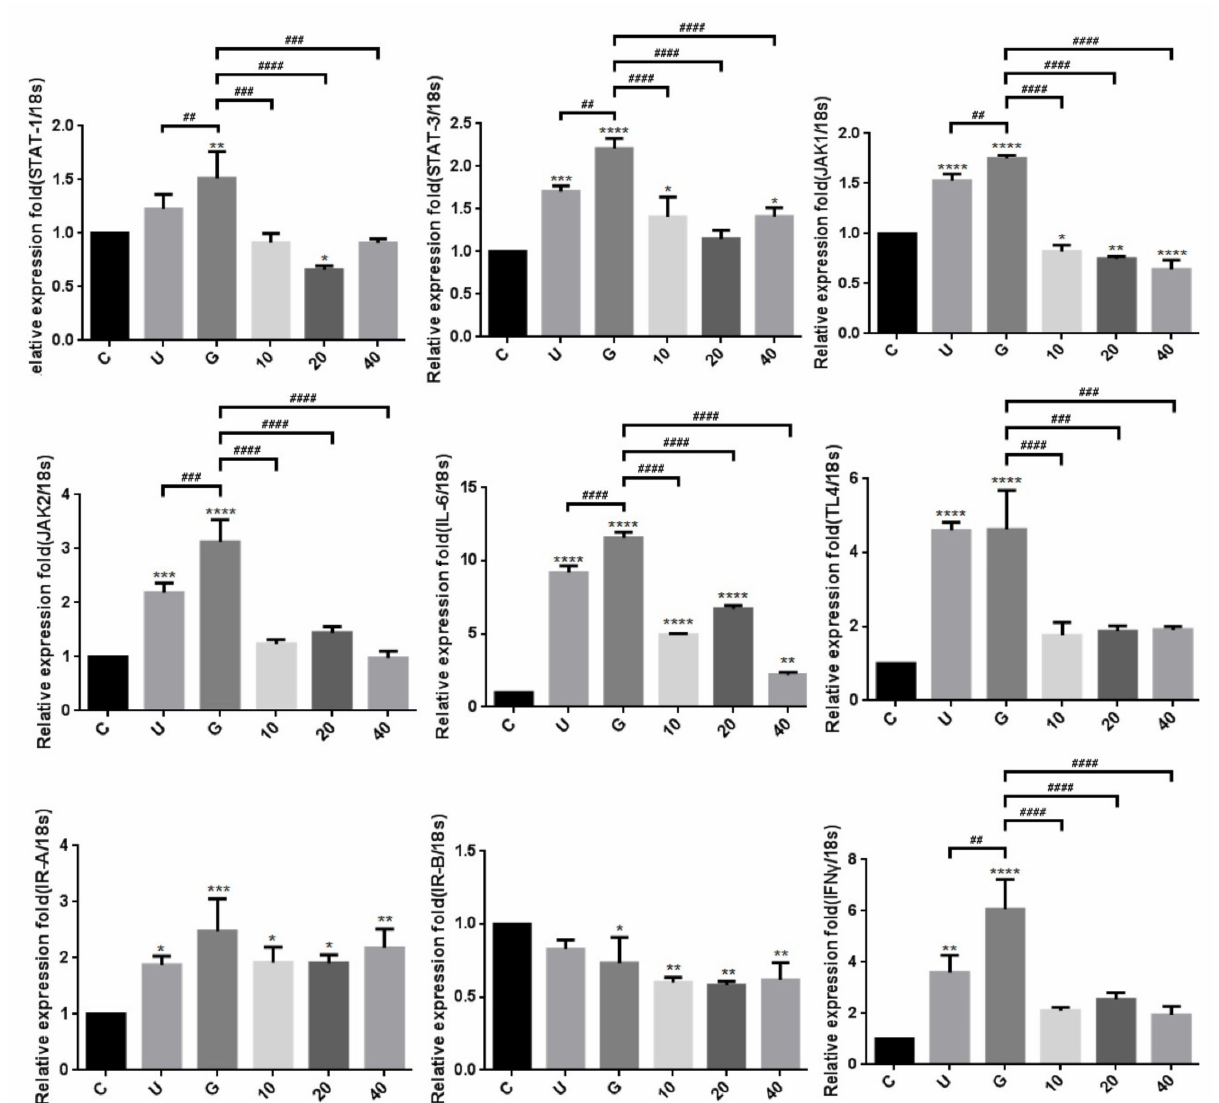
Figure 6. Transcriptional effects of insulin on JAK/STAT1 signaling pathway in UPEC-infected bladder cells in a high- glucose environment. Total RNA was isolated from treated cells and analyzed using qPCR. The mRNA levels of JAK1, JAK2, STAT1, STAT3, IFN- γ , IL-6, TLR-4, and IR- α / β were detected in UPEC-infected bladder cells with different concentrations of insulin and 15 mM glucose pretreatment for 24 h. The definitions of each letter/number represented by the X axis are: C: control; U: UPEC infection alone; G: with 15 mM glucose pretreatment; 10, 20 and 40: pretreated with 10, 20 and 40 µ g/mL insulin, respectively + 15 mM glucose. Data from three separate experiments are expressed as mean ± SD. * p < 0.05; ** p < 0.01; *** p < 0.001, **** p < 0.0001, compared to positive control groups. ## p < 0.01, ### p < 0.001, #### p < 0.0001, compared between the two